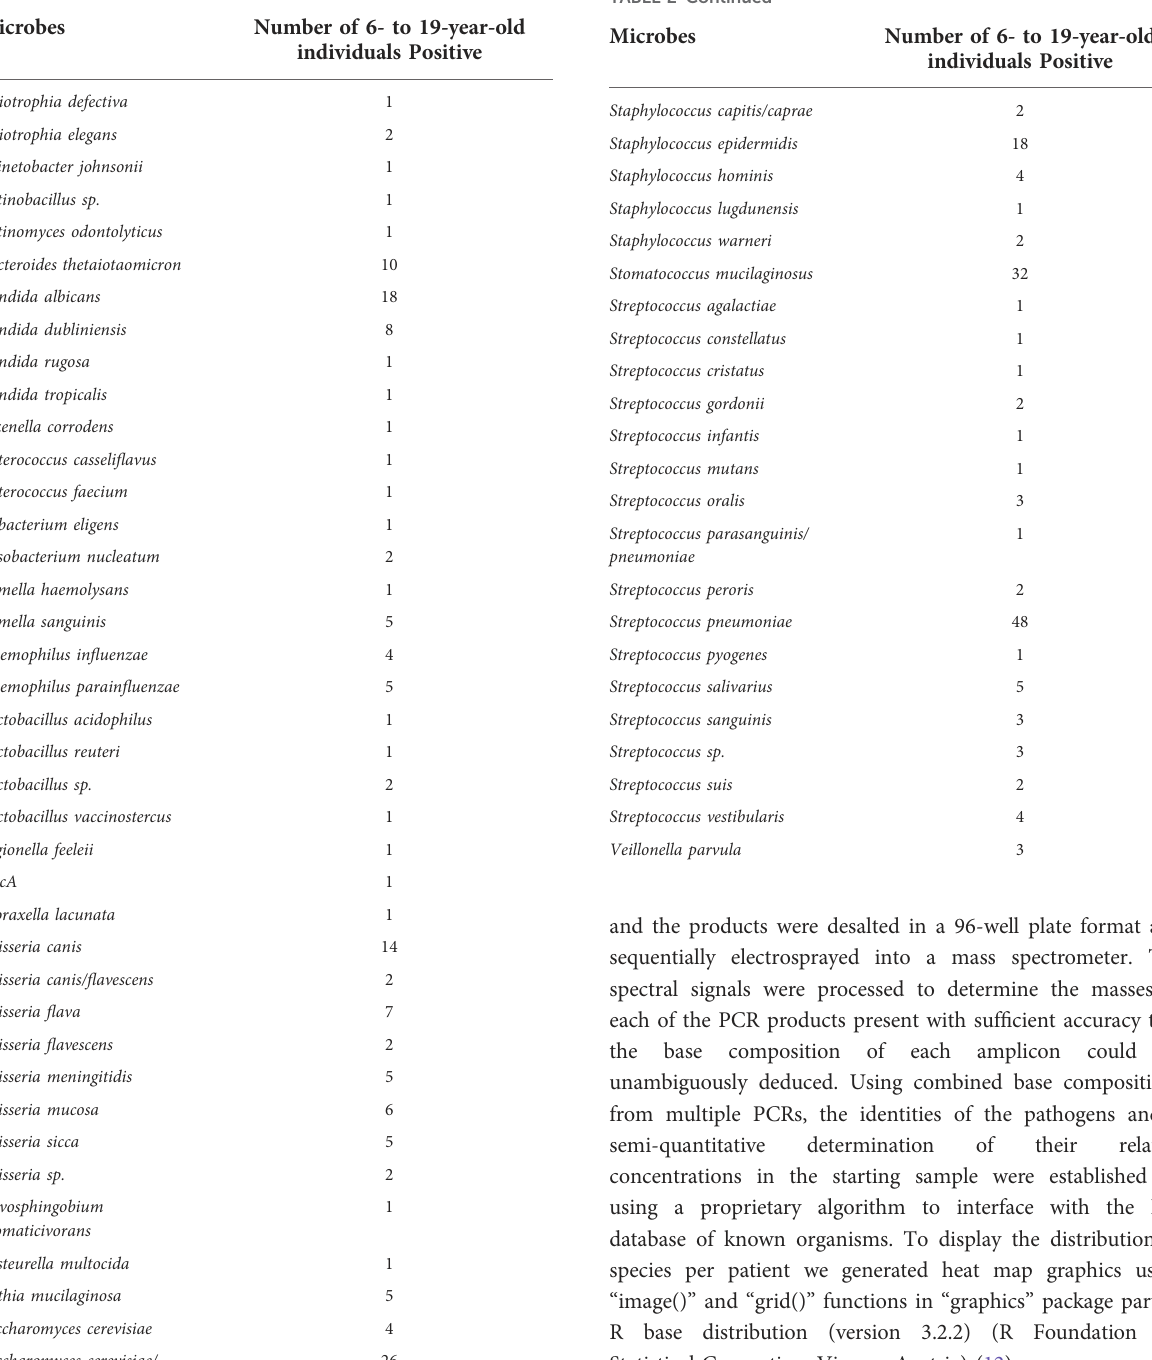
TABLE 2 Microbes identi fi ed in the